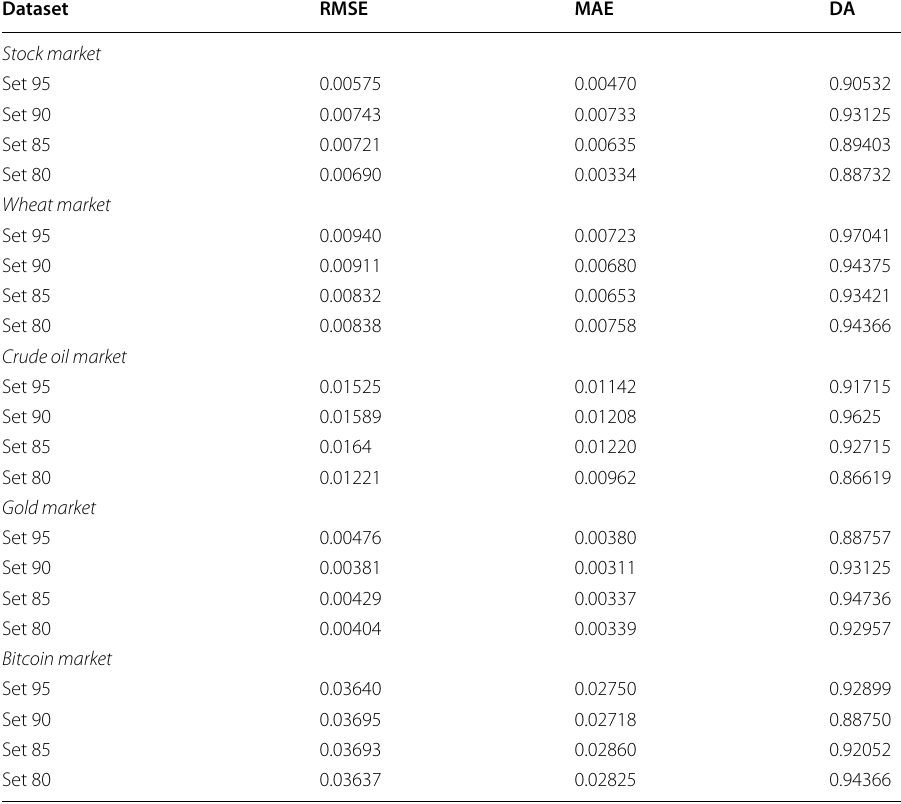
Table 4 Robustness test with different datasets